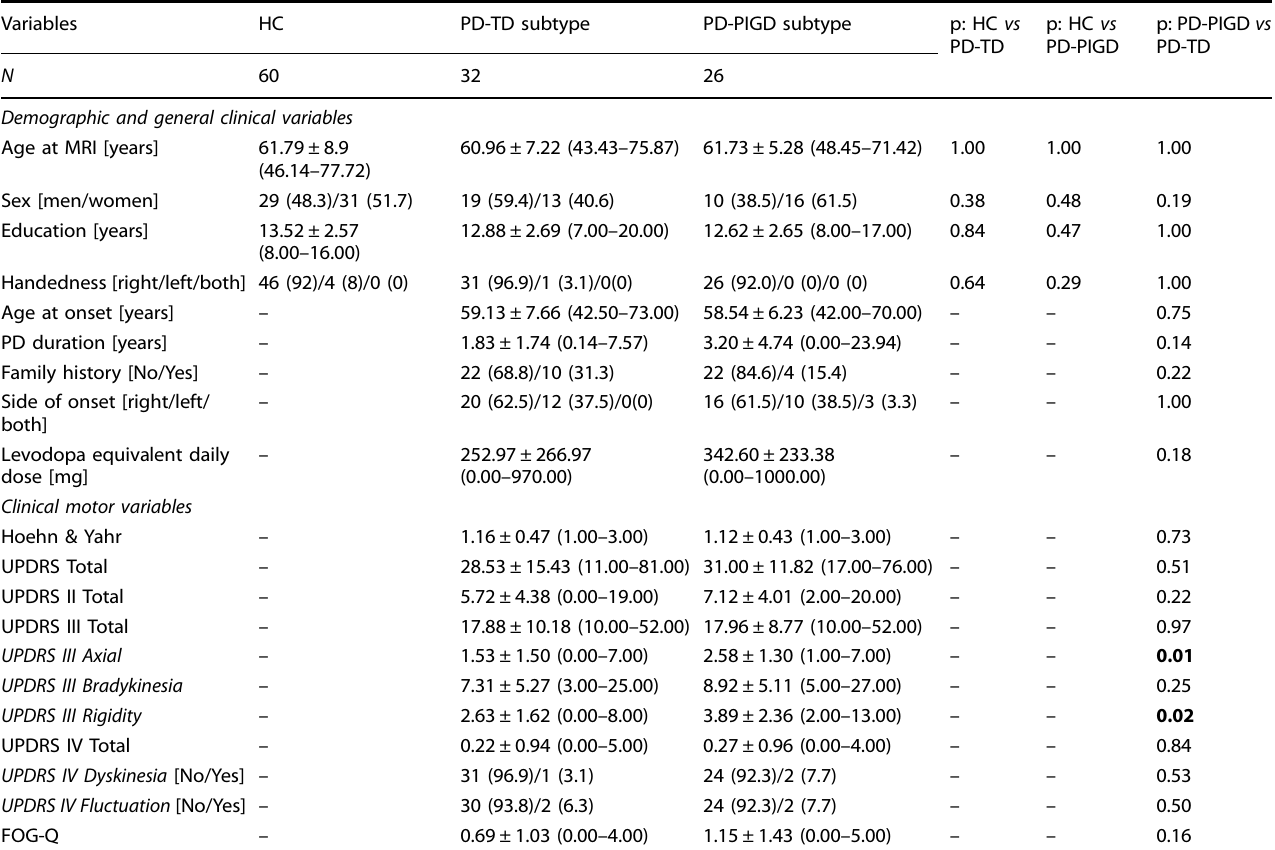
Table 1. Demographic and clinical characteristics of healthy controls, PD-TD and PD-PIGD